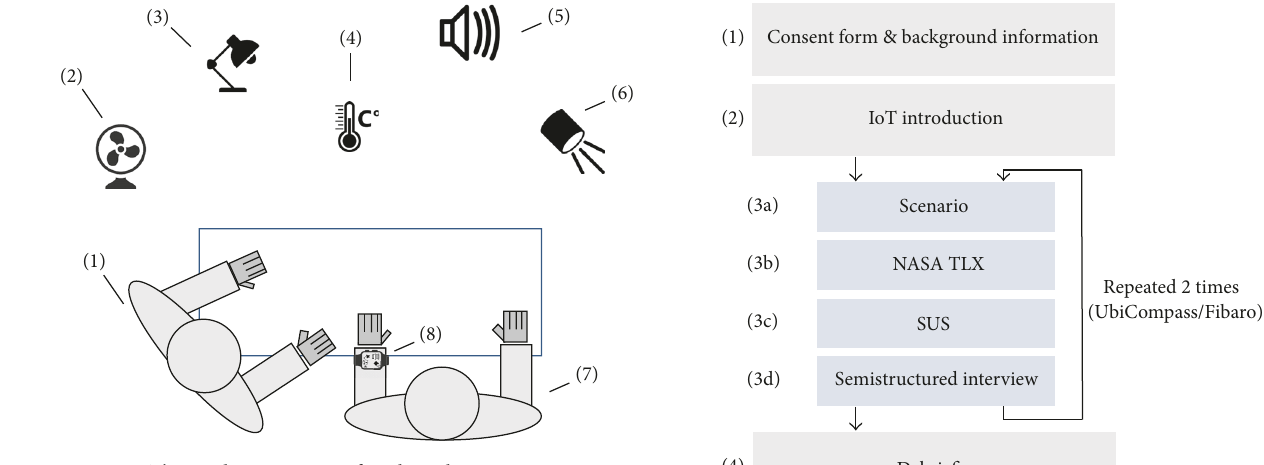
Figure 5: The evaluation setup for the UbiCompass prototype. (1) Test leader, (2) fan, (3) desk lamp, (4) thermometer, (5) sound system, (6) dimmable spotlight, (7) test participant, and (8) smartwatch. For the Fibaro application condition, the smartwatch was replaced with a smartphone.